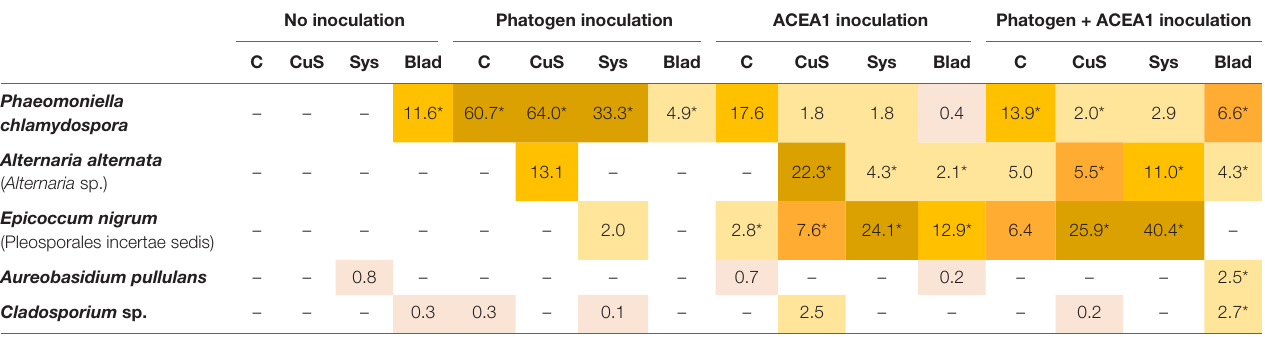
TABLE 3 | Relative abundance of inoculated fungi in plants that were subject to different fungicide